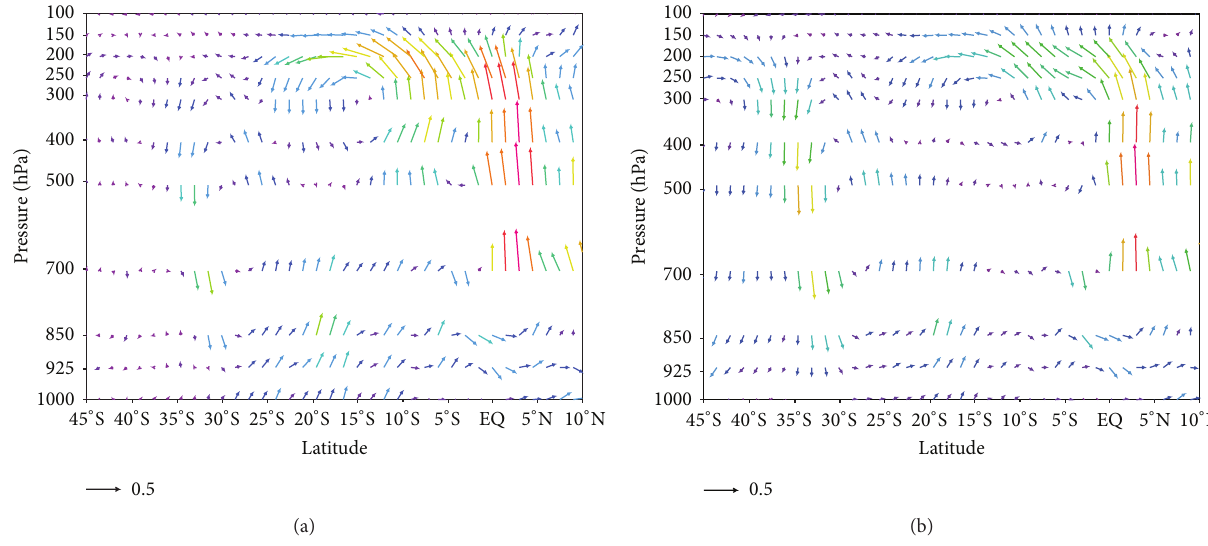
Figure 3: Annual mean of the HCSA anomaly based on the Era-Interim reanalysis for (a) strong cases and (b) poleward expansion cases. The vertical velocity has been multiplied by − 100. The color scale represents the vector’s magnitude.